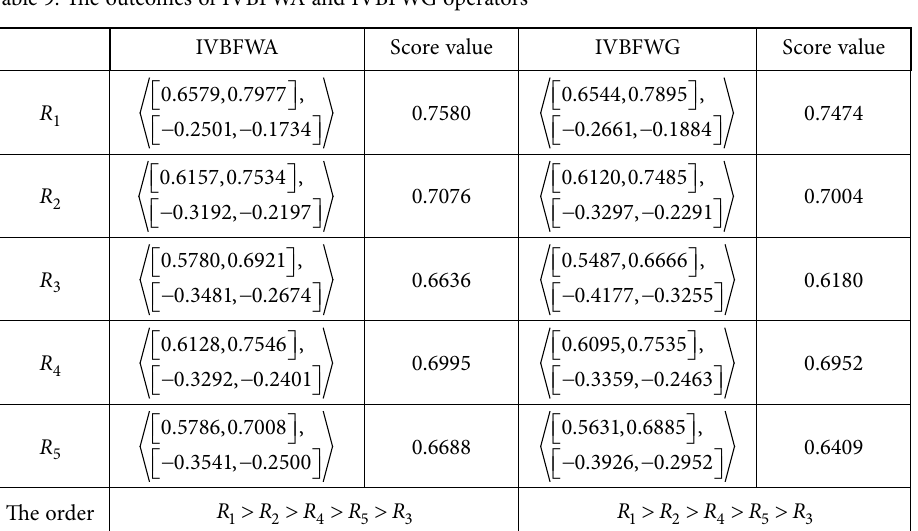
0.1 0.2 0.3 0.4 0.5 Figure 1. The outcomes of parameters p and k varying simultaneously Table 9. The outcomes of IVBFWA and IVBFWG operators